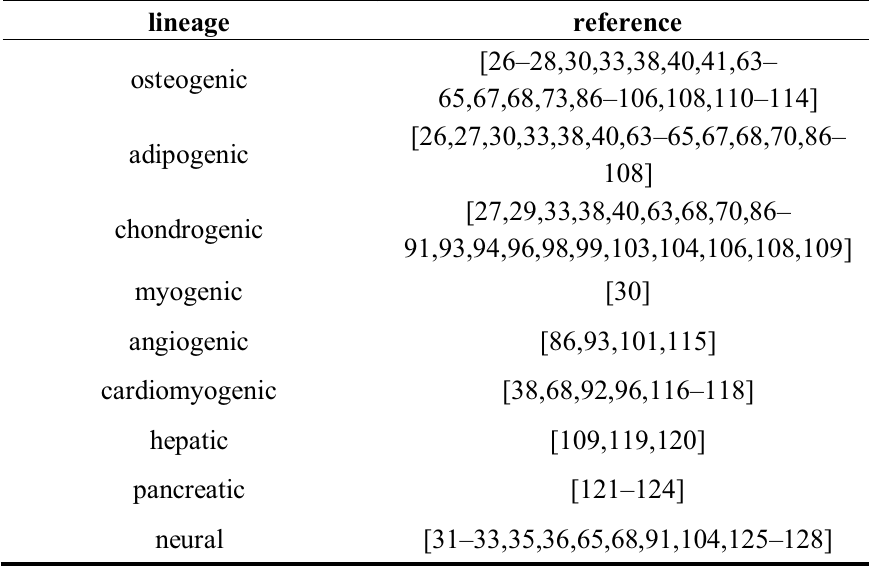
Table 3. Overview of the reported differentiation potential of UC-derived